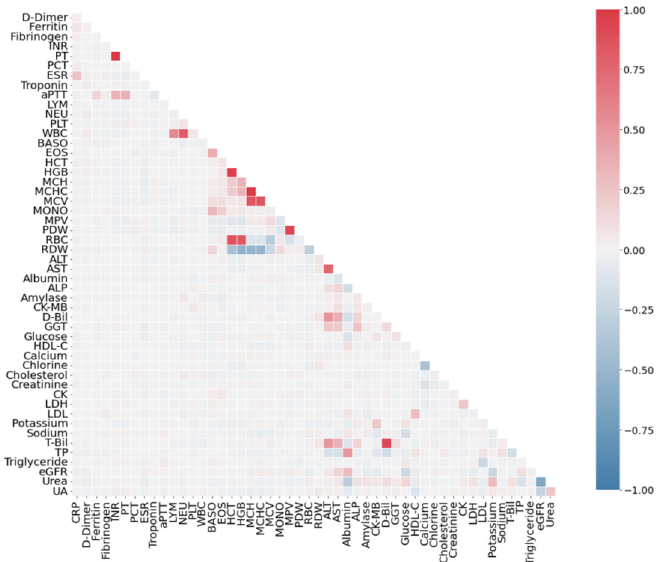
Figure 4. Pearson correlation analysis results for negative diagnoses for COVID-19 from the SARS- CoV-2-RBV1 dataset.